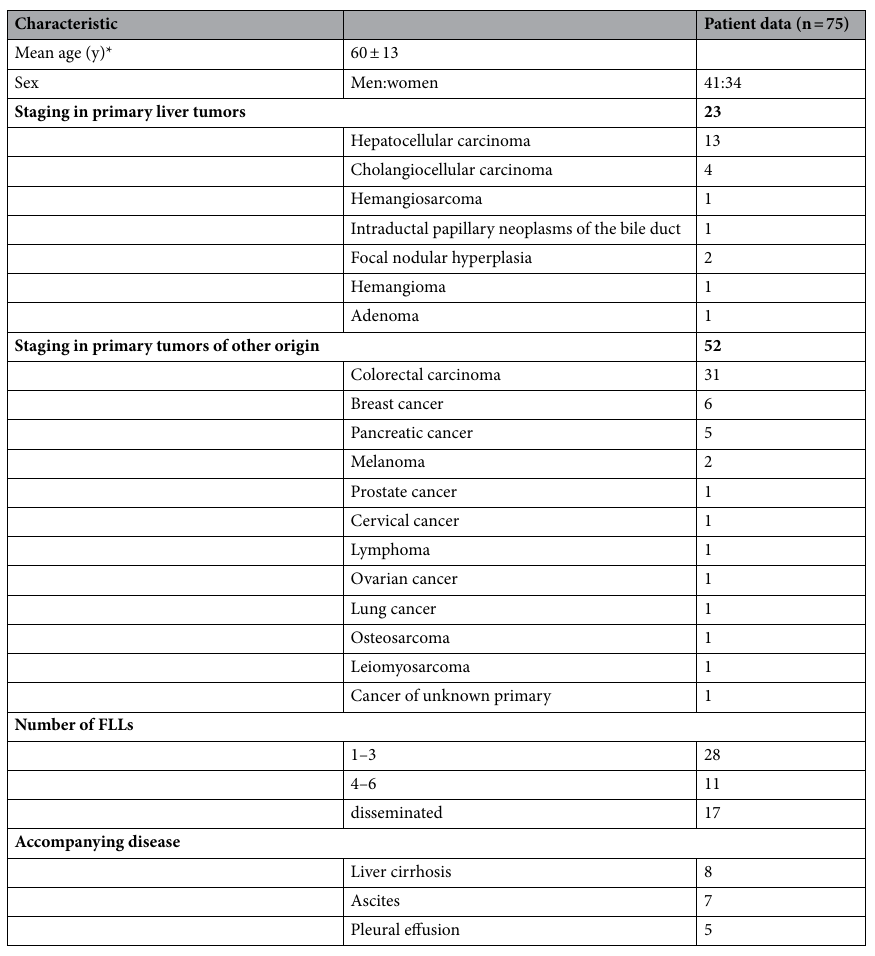
Table 2. Characteristics of the patients included in the